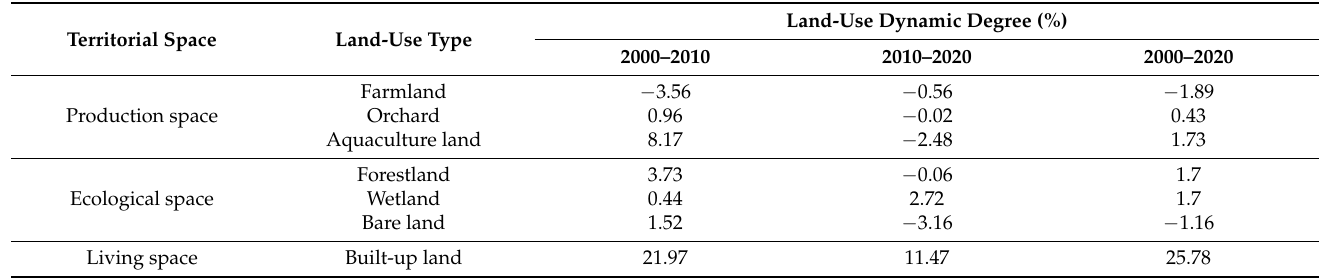
Table 6. Land-use dynamic degree during 2000 and 2020 in the study area.